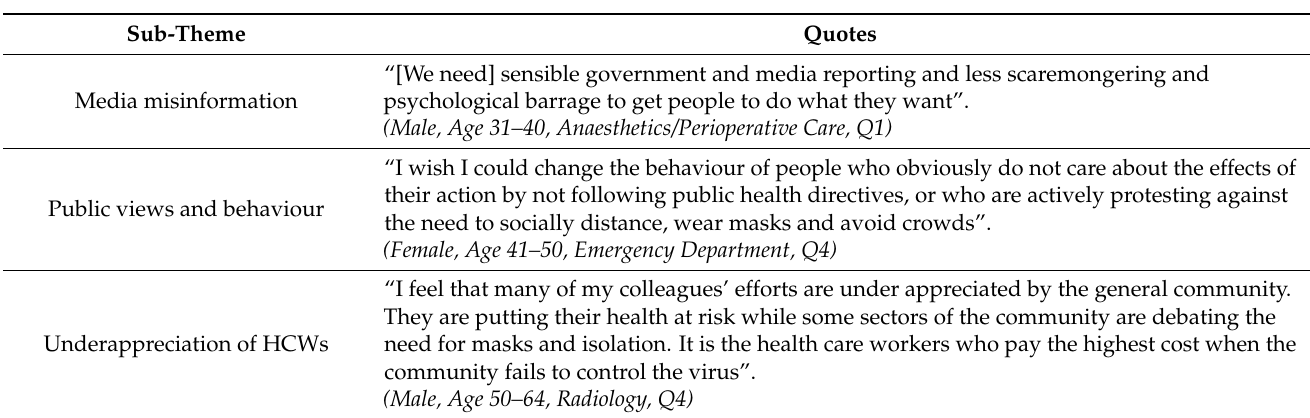
Table 6. Media and community